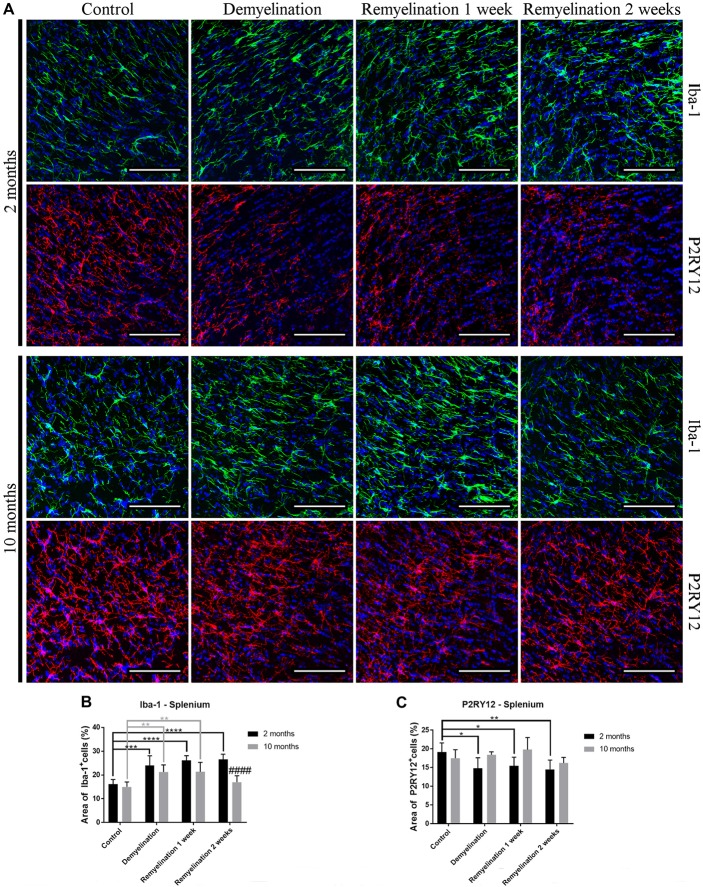
Age- and region-dependent differences in Iba-1 and P2RY12 during de- and remyelination in the splenium of the CC. (A) Iba-1 (green) and P2RY12 (red) labeling. Cell nuclei are stained with DAPI (blue). (B) In young mice, Iba-1 was up-regulated during all phases of de- and remyelination, while in the middle-aged group Iba-1 returned to control levels after 2 weeks of remyelination, resulting in an age-related difference at this time point. (C) A significant reduction of P2RY12 in the splenium was observed only in the younger group during de- and remyelination. In the middle-aged group P2RY12 levels were not changed during de- or remyelination. Values are shown as means + SD (n = 6 per group). Statistical significance was evaluated using a two-way ANOVA and a Tukey’s post hoc test. The p-values are indicated in the graphs: treatment effects within the same age group: *p < 0.05, **p < 0.01, ***p < 0.001 and ****p < 0.0001, age-related differences: ####p < 0.0001. Bars: (A) 100 μm.